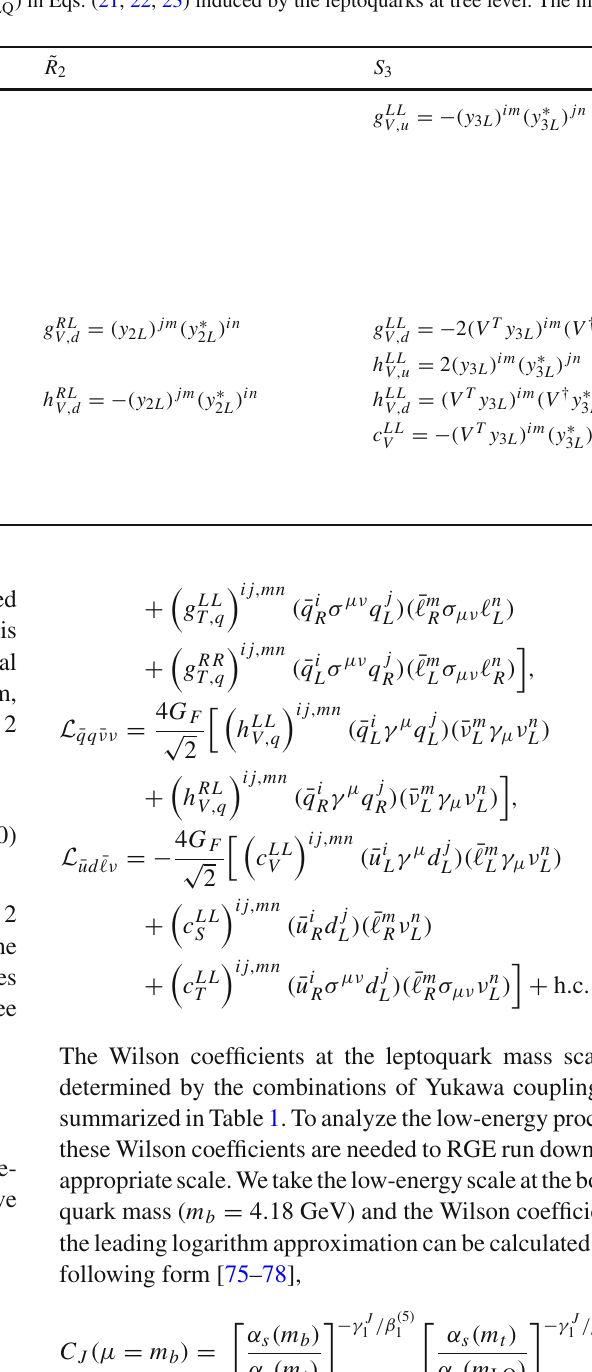
) in Eqs. (21, 22, 23) induced by the leptoquarks at tree level. The matching LQ